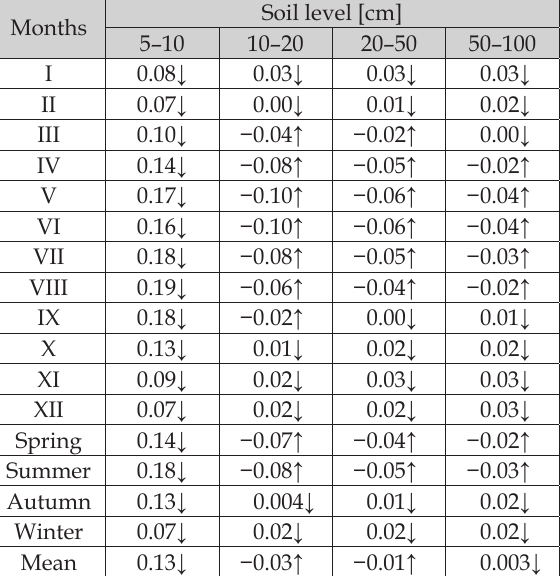
ues of the thermal gradient [°C · cm −1 ] in Poznań